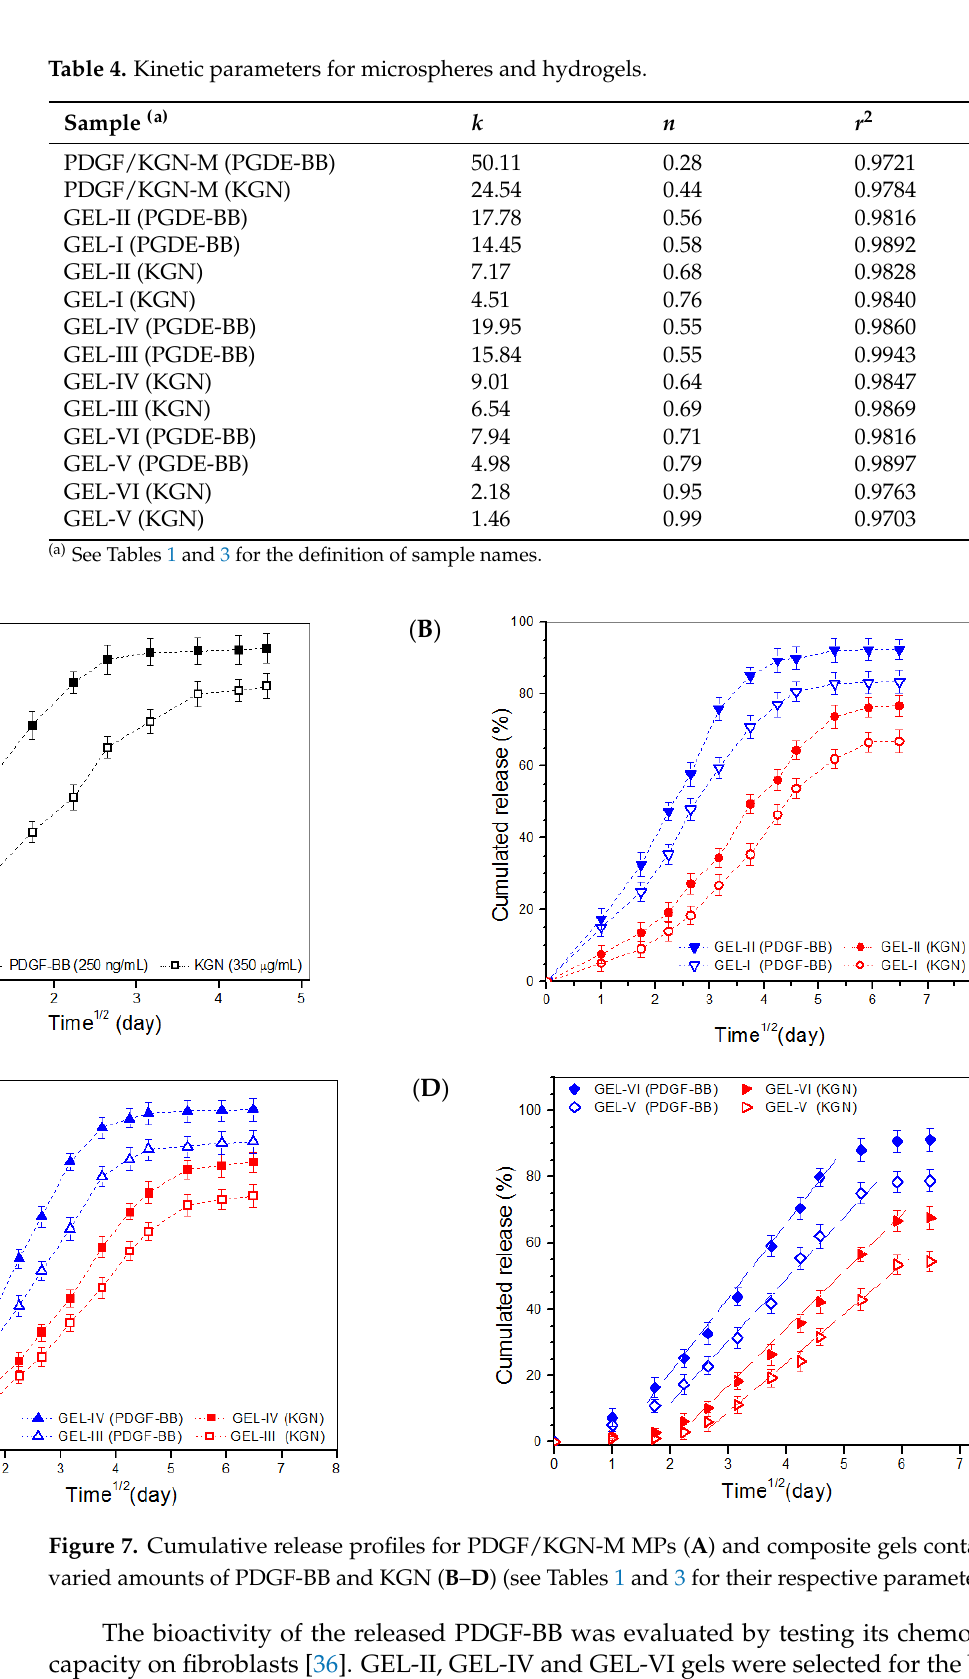
Table 4. Kinetic parameters for microspheres and hydrogels.